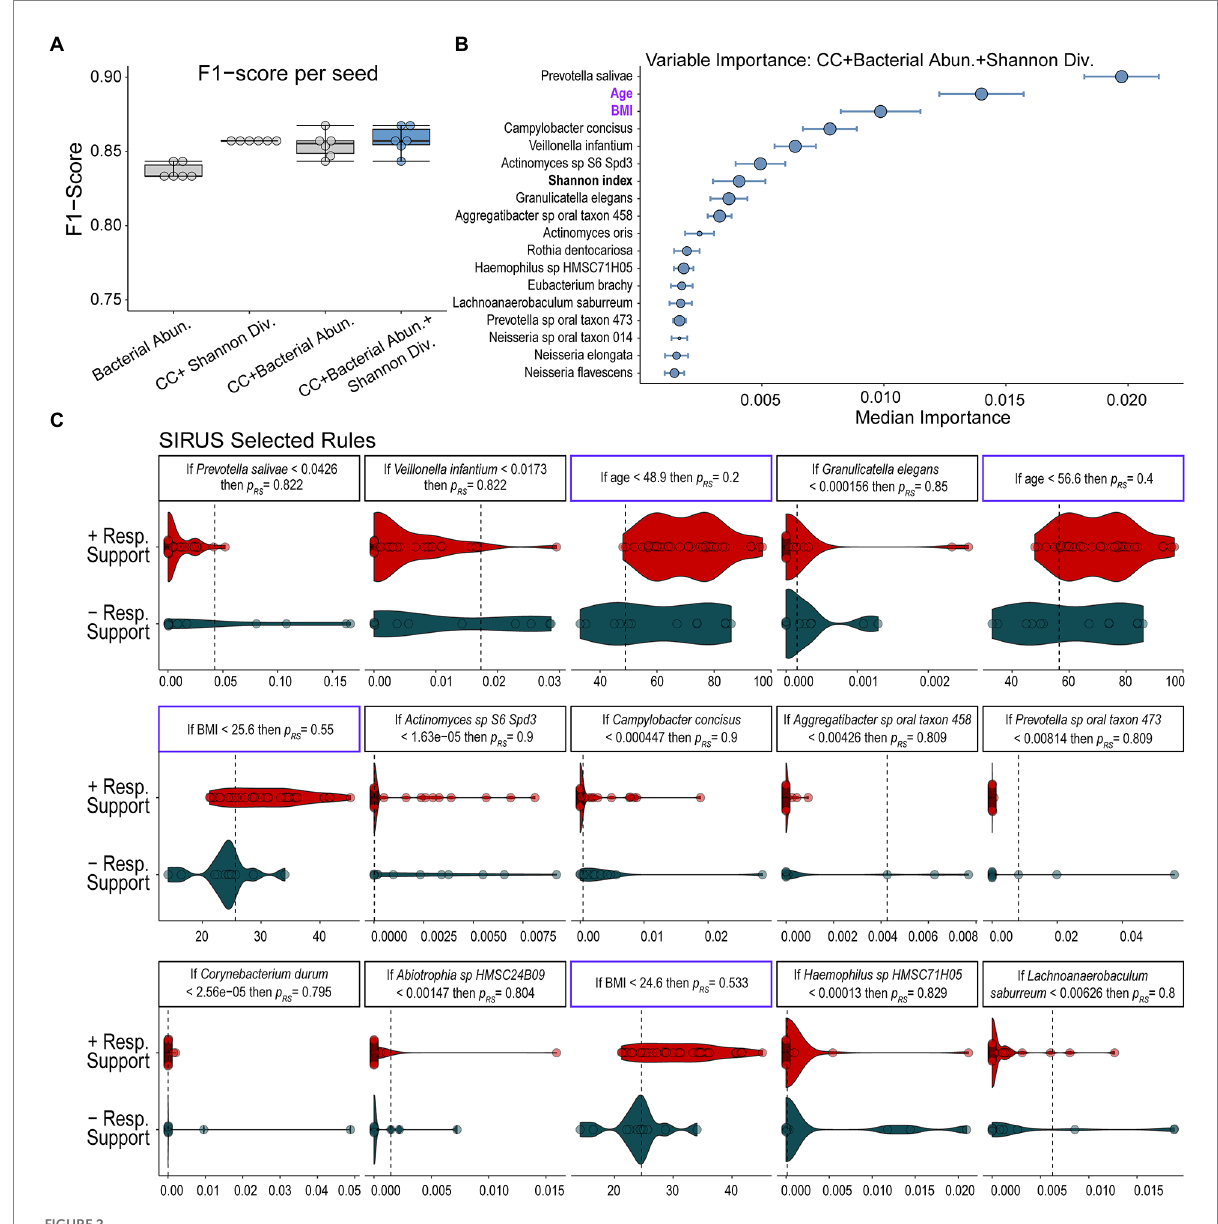
FIGURE 2 Results of random forest classification model. (A) F1-scores of RFC models including clinical covariates (CC), individual microbial abundances, and the combination of bacterial abundances, alpha diversity, and clinical covariates show that all models perform well with models including all multimodal data performing slightly better. (B) Median ranked importance of features from the final model (blue boxplot) trained on all data including microbiome features, alpha diversity, and clinical data (median importance ± median absolute deviation) are shown. The size of the circle represents how often each feature was selected. The relative abundance of Prevotella salivae is the top predictor with the relative abundance of Campylobacter concisus , V. infantium and Actinomycetes sp. S6-Spd3 and the Shannon diversity index also showing significant contributions. Significantly contributing clinical covariates were age and BMI. Features which do not contribute to the predictive model are not shown. (C) The relative abundance of the microbiome features or values of clinical variables determined to be important in predicting the need for